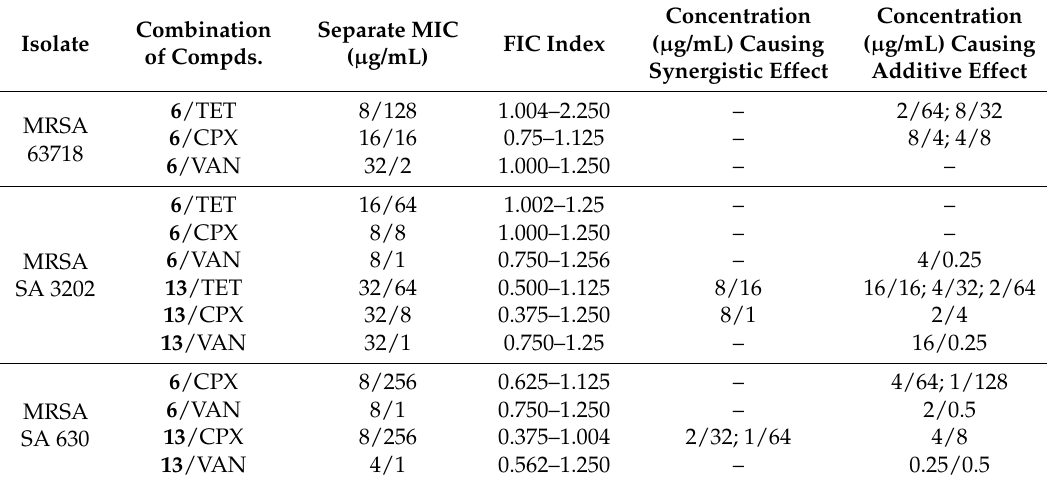
Table 3. Combined effect of most potent N -arylcinnamamides and tetracycline (TET), ciprofloxacin (CPX), and vancomycin